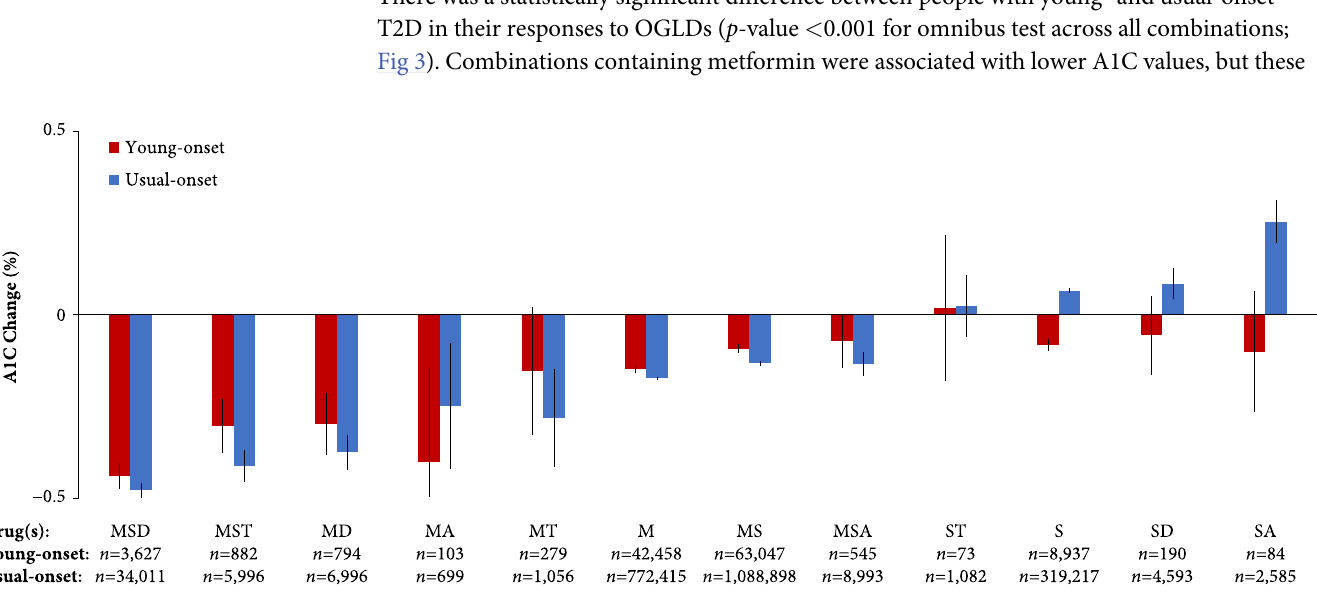
Fig 3. A1C responses to oral glucose-lowering drugs among people with young- and usual-onset type 2 diabetes. These insulin-naive individuals were observed during the first decade after diabetes diagnosis (population cohort, Hong Kong Diabetes Surveillance Database, 2002–2016). Sample sizes (number of A1C measurements) are indicated for each combination. Error bars indicate 95% confidence intervals. Differences between young- and usual-onset type 2 diabetes were statistically significant across all combinations (omnibus test p < 0.001). A, acarbose; D, dipeptidyl peptidase-4 inhibitor; M, metformin; S, sulfonylurea; T,